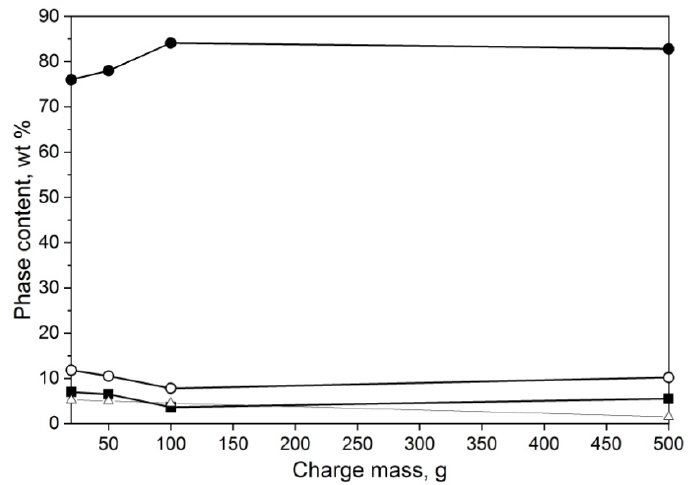
Figure 6. Phase composition of powder mixtures obtained by the means of SHS method for different powder mass batches, γ -AlON ( ● ), Al 2 O 3 ( ○ ), AlN ( ■ ), and Al 7 O 3 N 5 ( ∆ ).